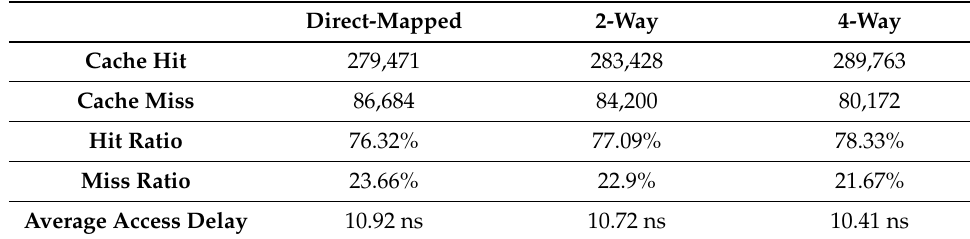
Table 5. Comparison of hit and miss rates of 25 K keys.